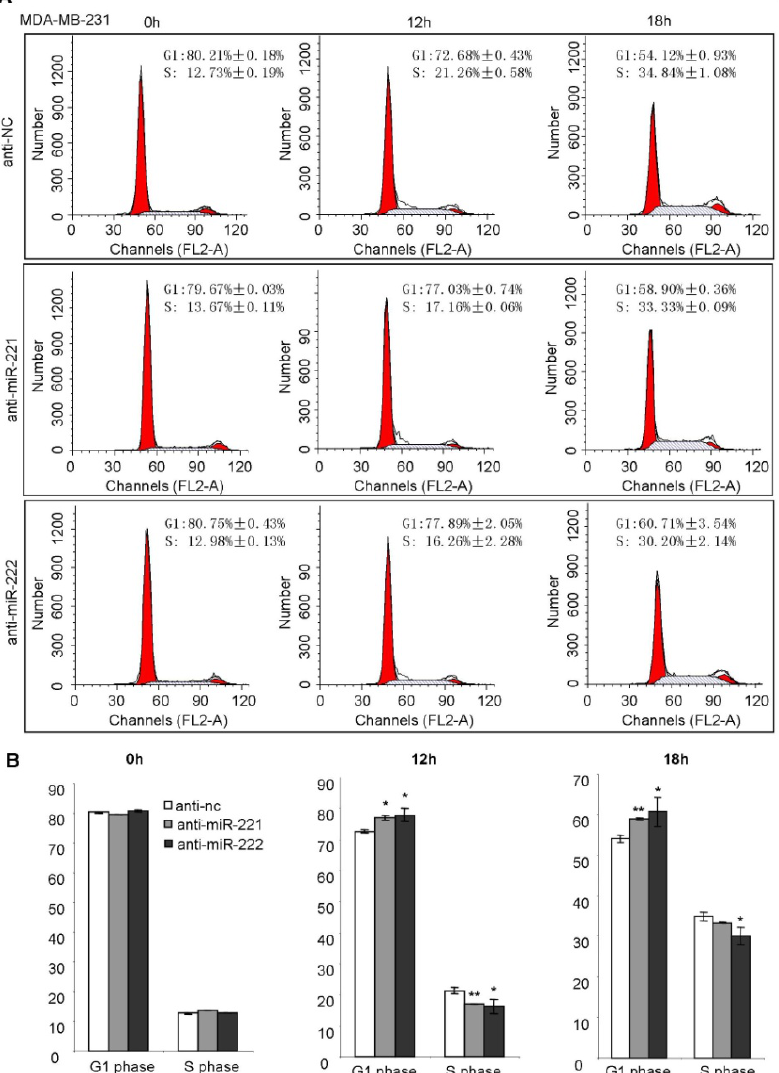
/S transition by 1